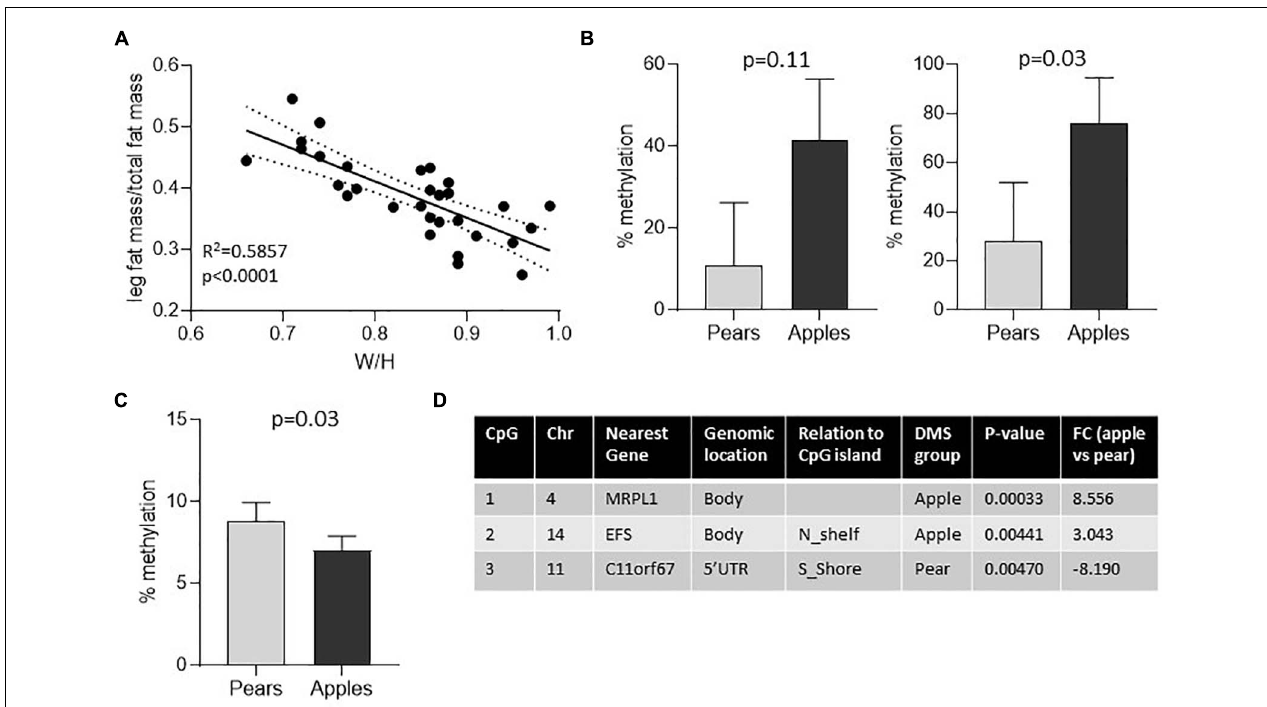
FIGURE 3 | Three of 5 body shape specific DMS found in blood were validated in an independent group of women. (A) Linear regression shows positive association between waist to hip ratio and the ratio of fat accumulated in the legs relative to the total fat mass in the initial group of women. (B,C) Percentage of DNA methylation in 5 apple- vs. 5 pear-shaped women for 2 apple shaped-specific DMS (B) and 1 pear shaped-specific DMS (C) . Mean ± SEM is shown. The p -value of non-parametric Mann Whitney test are reported Level of CpG sites methylation was measured by pyrosequencing in DNA isolated from total blood samples. (D) Genomic characteristics of the CpG sites showing differential level of methylation between apple- and pear-shaped women. Chr, Chromosome, DMS, Differentially Methylated Sites, FC, Fold